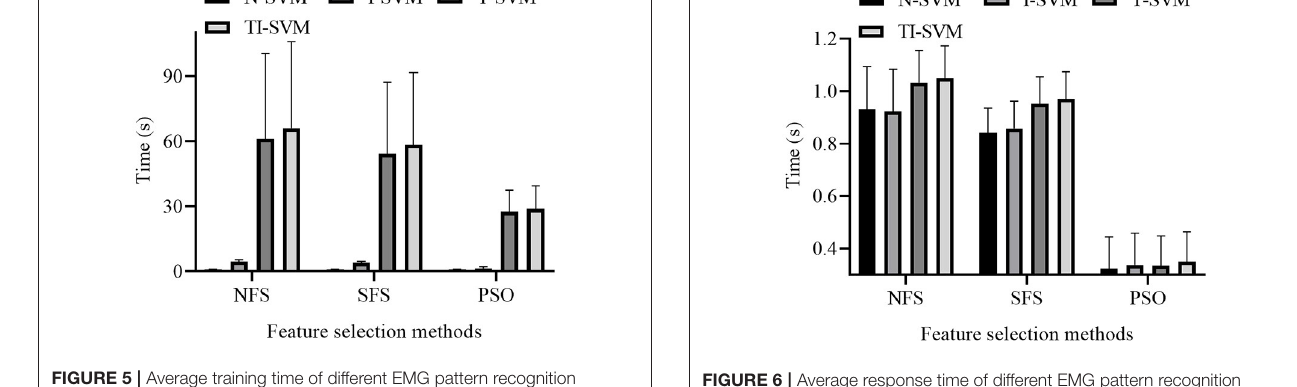
FIGURE 6 | Average response time of different EMG pattern recognition scheme of 12